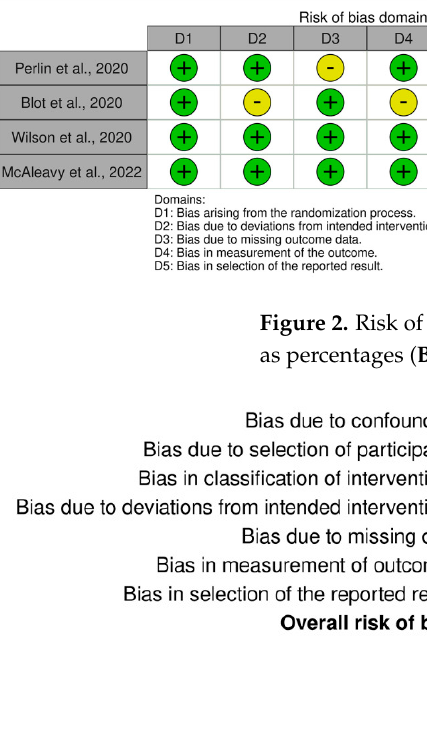
Figure 3. Overall risk of bias in non-randomized studies. Categories are presented as percentages.